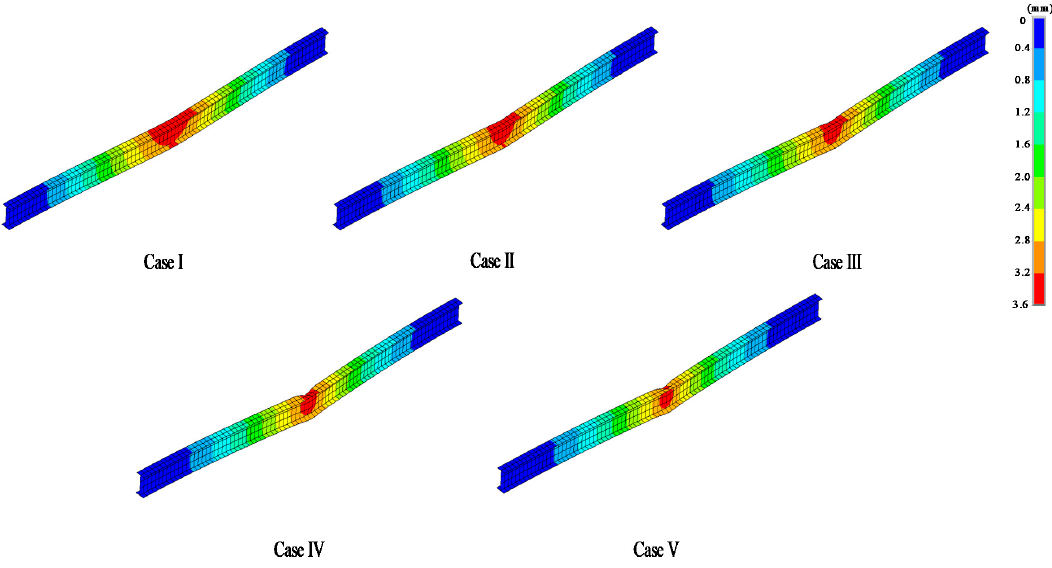
Figure 29. Deflection of the H-beam under a propane burner fire at 4000 s.